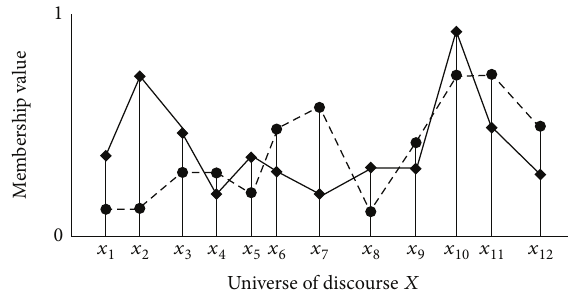
Figure 1: Overlapped data